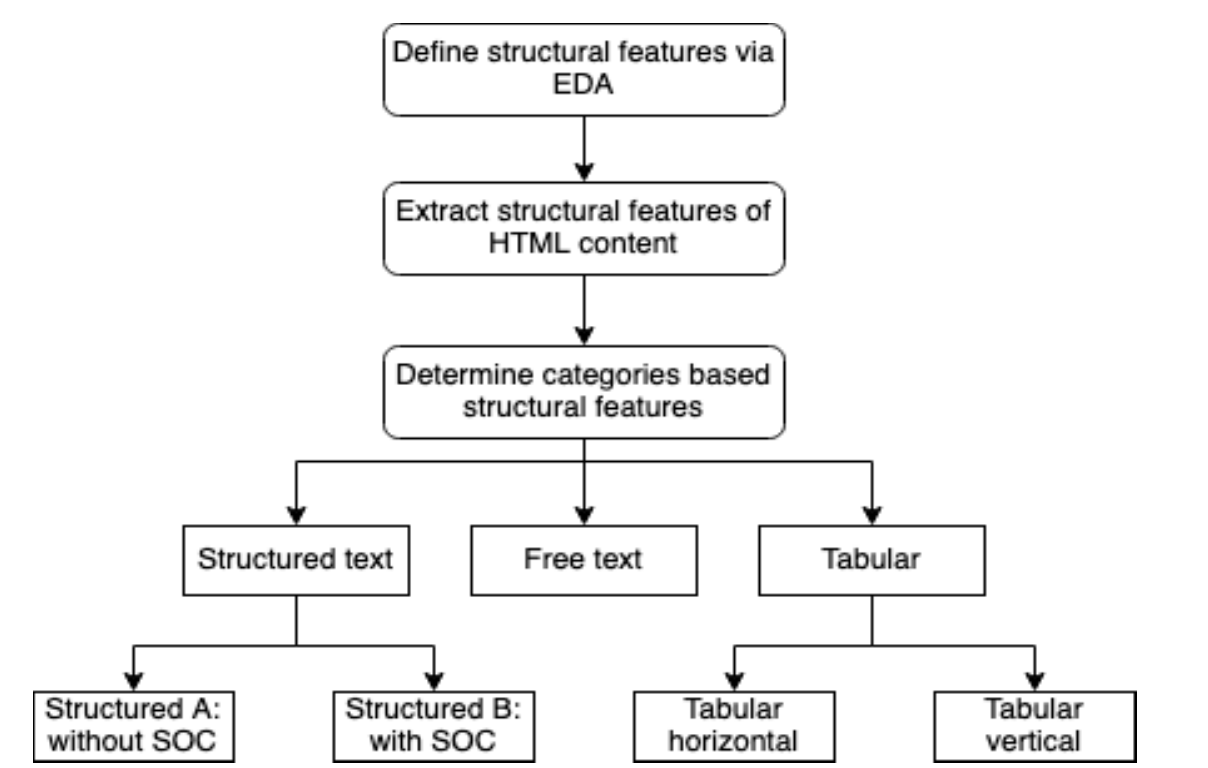
Figure 3. A decision tree for classifying the ADR content during SmPC processing.